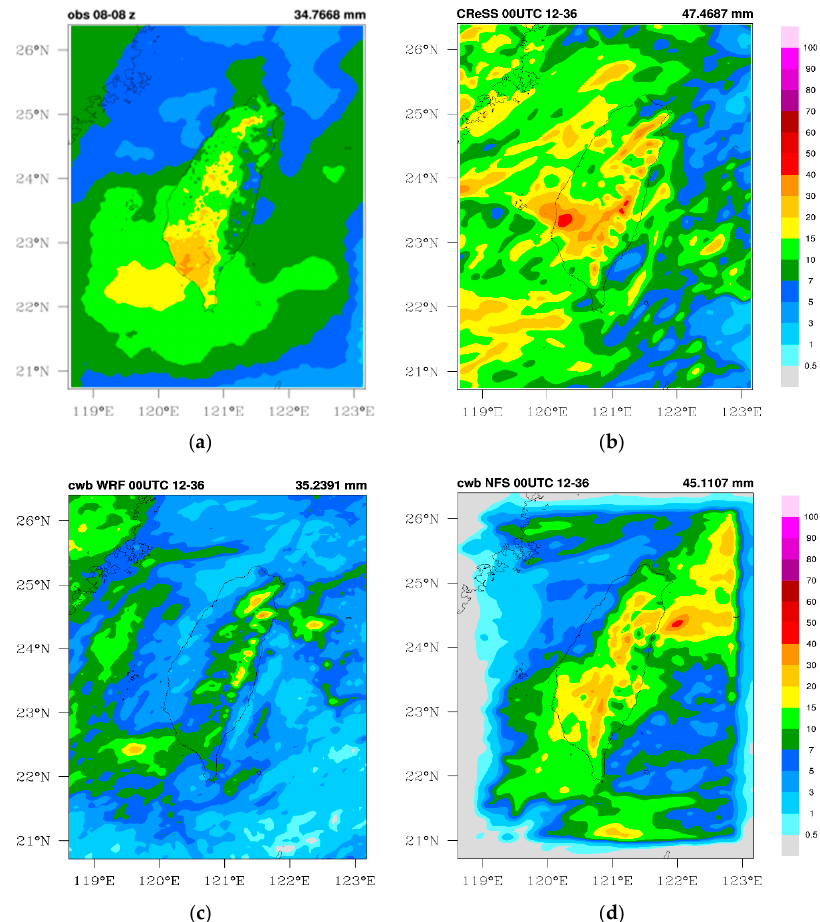
Figure 1. ( a ) Observed and predicted mean daily rainfall (mm, 0000–2400 UTC) distributions over Taiwan by the three models: ( b ) Cloud-Resolving Storm Simulator (CReSS), ( c ) Central Weather Bureau (CWB) Weather Research and Forecasting (WRF), and ( d ) CWB Non-hydrostatic Forecast System (NFS), during the period of South-West Monsoon Experiment (SoWMEX), from 15 May to 30 June 2008. The model initial time is 0000 UTC, at the range of 12–36 h. The maximum amount is given at the right side above each panel.